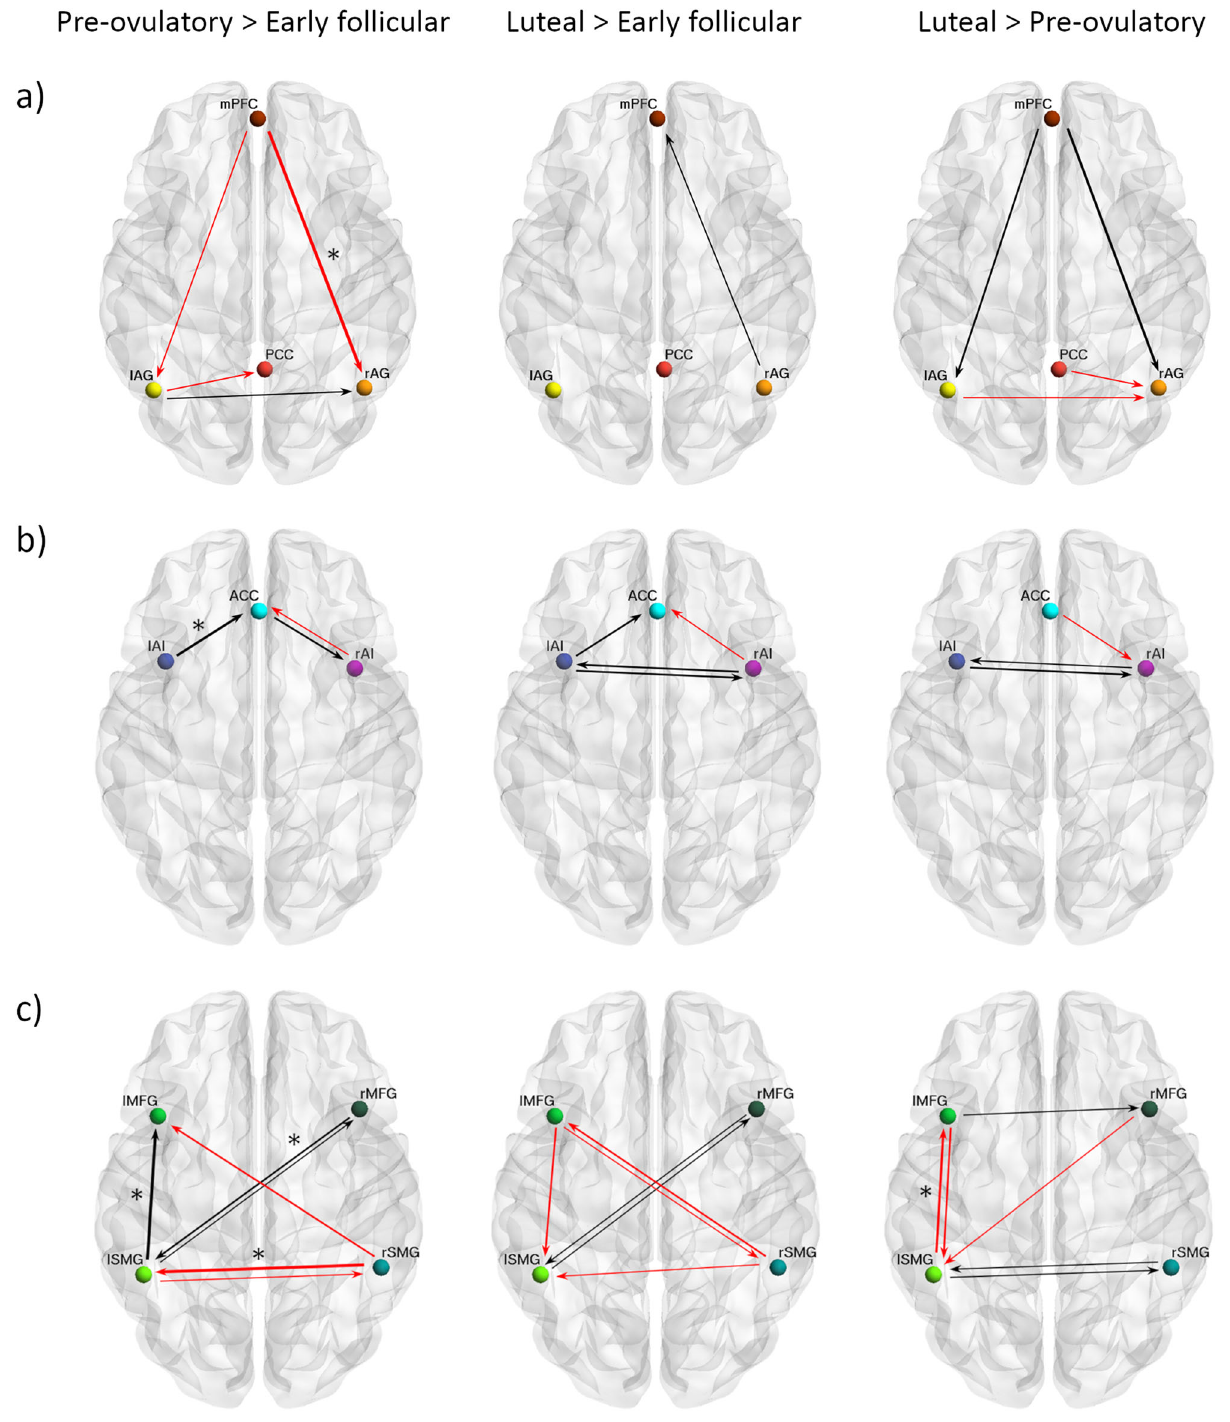
Fig. 2 Cycle phase differences in within-network effective connectivity. a DMN; b SN; c ECN. Only connections with a posterior probability >0.75 are displayed. Connections surpassing a posterior probability of 95% are indicated with an asterisk. The results re fl ect connection strengths as a difference between the indicated cycle phases. The differential connection strengths are depicted by the width of the arrow. Black arrows re fl ect positive values and red arrows re fl ect negative values for those connections which showed differences in the former than in the latter indicated cycle